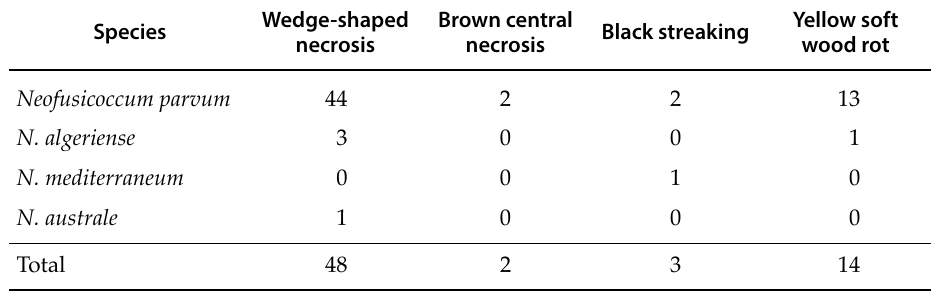
Table 2. Neofusicoccum species isolated from different types of diseased tissues in grapevines with dieback